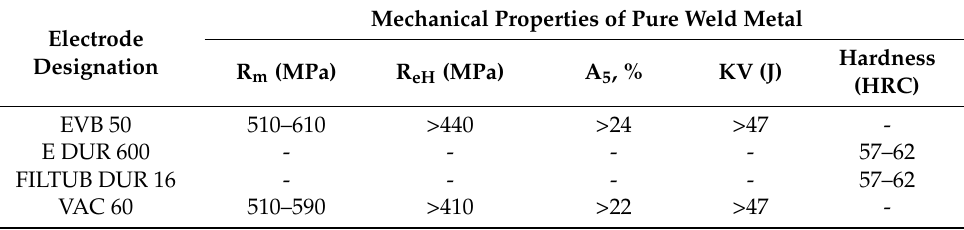
Table 7. Mechanical properties of the weld metal obtained by application of the tested filler